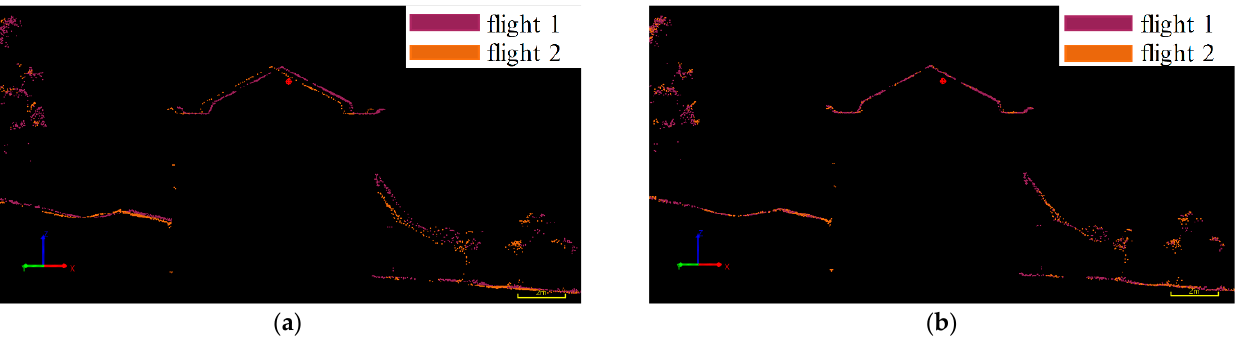
Figure 19. Parallel section of point cloud in in opposing flight strips (flight 1 and flight 2). ( a ) Without installation angle compensation; ( b ) With installation angle compensation.